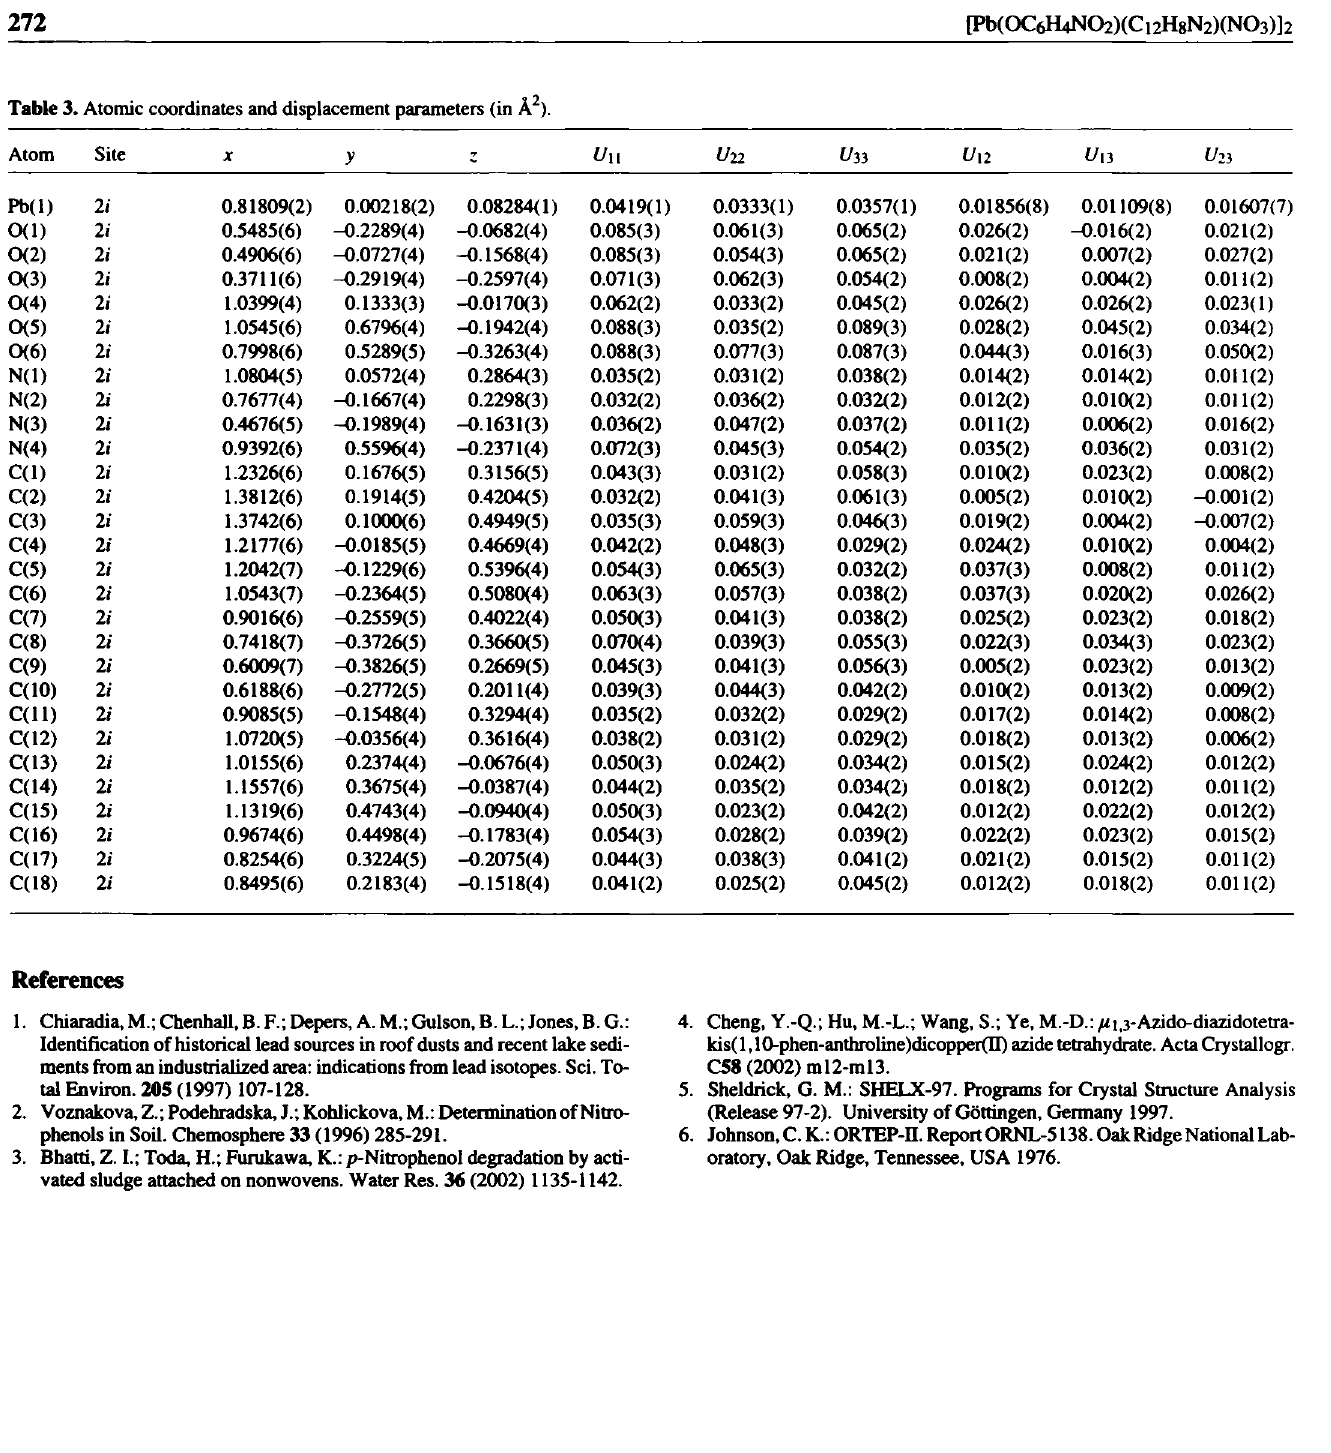
Table 3. Atomic coordinates and displacement parameters (in A 2